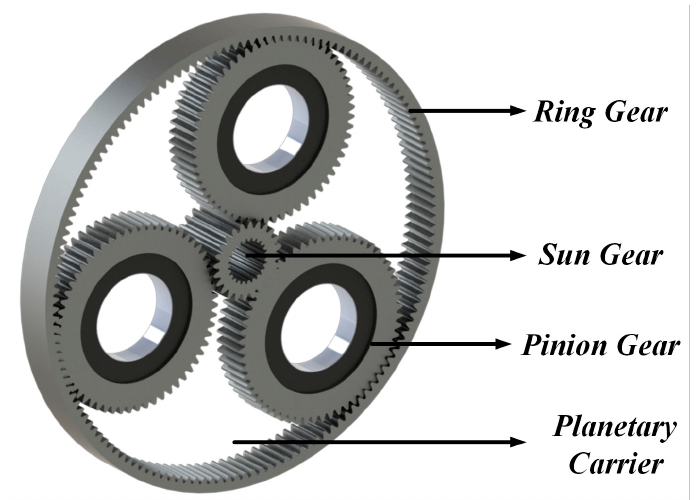
Figure 20. Planetary gear system [ 31 ].